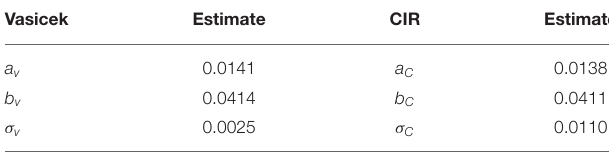
TABLE 2 | Quasi-maximum likelihood estimation of Vasicek and CIR